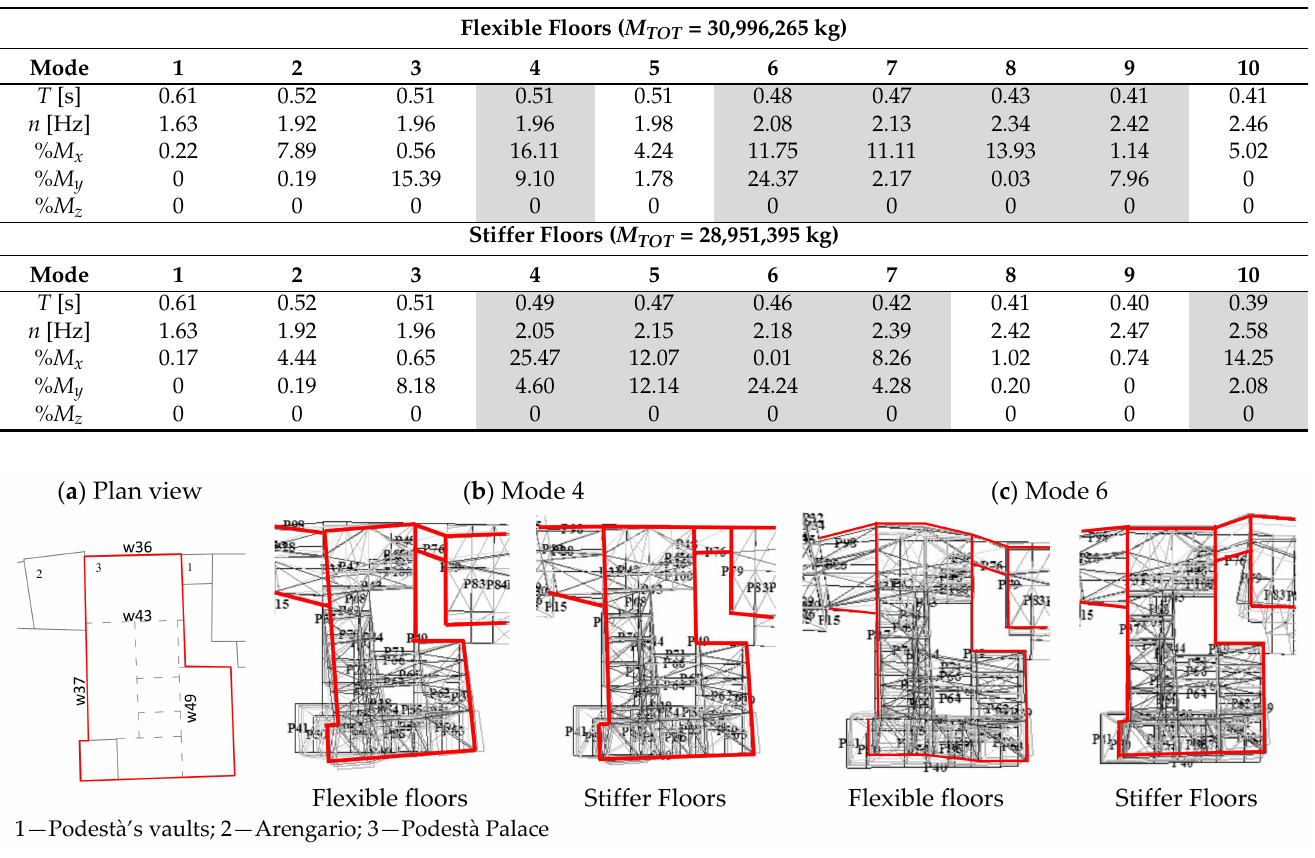
Figure 9. ( a ) Identification of mainly interacting units; comparison of modal shapes for Modes 4 ( b ) and 6 ( c ) in the configurations with flexible or stiffer